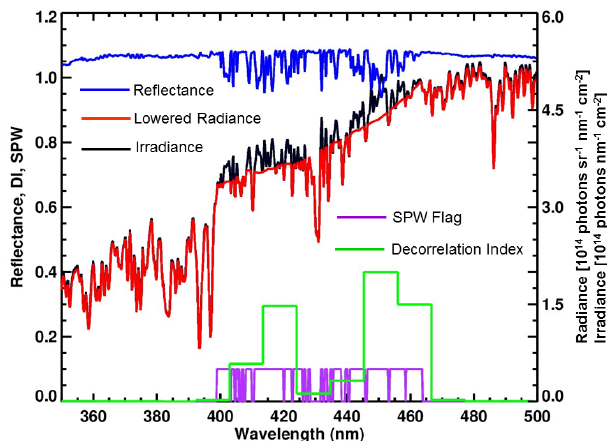
Figure 3. Similar to Fig. 2 but for iTimes 807, row 20, orbit 7990, 14 January 2006 in cloud region B (see arrows in Fig. 1c, d). The radiance was lowered by a few percent for better